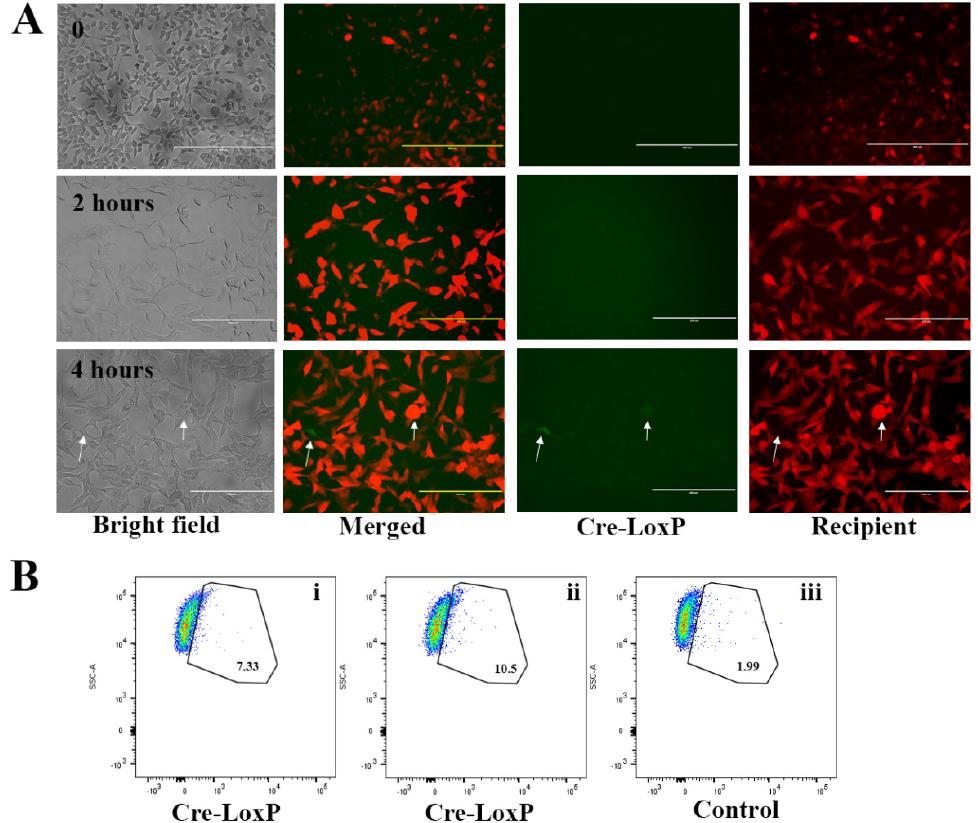
Figure 8. Uptake of EVs carrying Cre recombinase by T47D recipient tumour cells. Undiluted (100%) EVs carrying Cre-recombinase were added to T47D recipient cells (red). At 0, 2 and 4 h, bright field and fluorescent images were taken ( A ). Images were taken at 10 × magnification at time point 0. Other images were taken at 20 × magnification. Cre-LoxP cells which have a green fluorescent colour were located and shown with a white arrow, both in the bright field and fluorescent images. This uptake was also monitored using flow cytometry. Flow cytometry measurements were performed to assess the presence of Cre-LoxP cells which exposed green fluorescent signal after the co-culturing of EVs carrying Cre recombinase at a concentration of 50% and 100% for 4 h ( Bi – ii ). Controls were cells that were co-cultured with EVs without Cre recombinase ( Biii